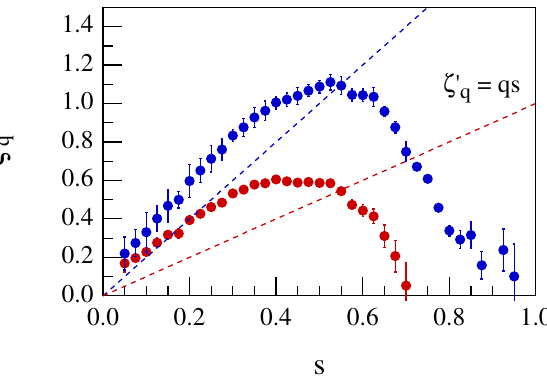
Fig. 4. Plot of ζ 0 ( q ) vs s for the determination of the scaling parameter s in the range Y ∈ [45 , 55] nT for q = 1 (red circles) and q = 2 (blue circles), respectively. The two dashed lines refer to ζ 0 ( q ) = qs with q = 1 (red) and q = 2 (blue), respectively.